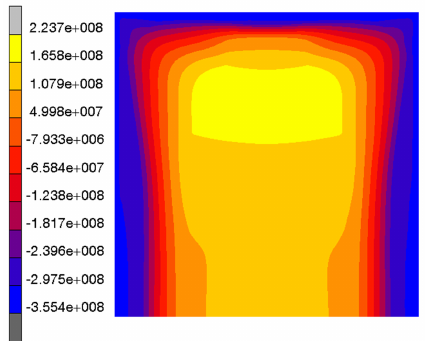
Figure 20. Stress 33—FEM heat treatment.